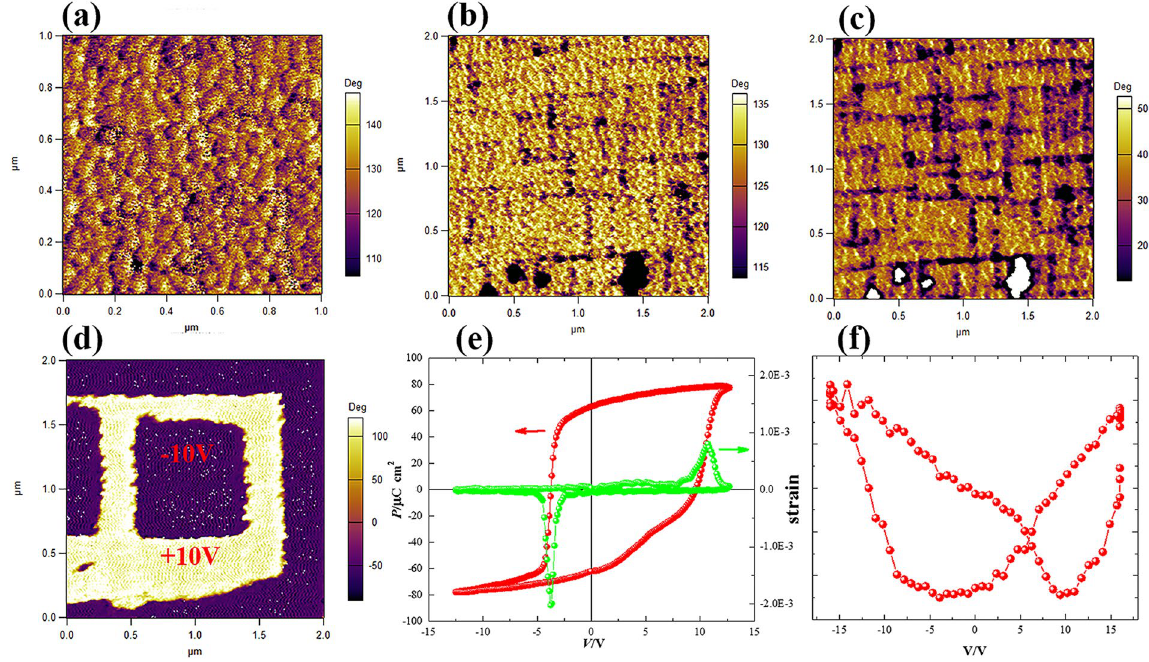
Figure 2. PFM images of the NSTO//PZT (150 nm) structure: ( a ) initial, ( b ) after written under + 6 V, ( c ) after written under − 6 V and ( d ) after written under ± 10 V, respectively. ( e ) Ferroelectric hysteresis and ( f ) strain